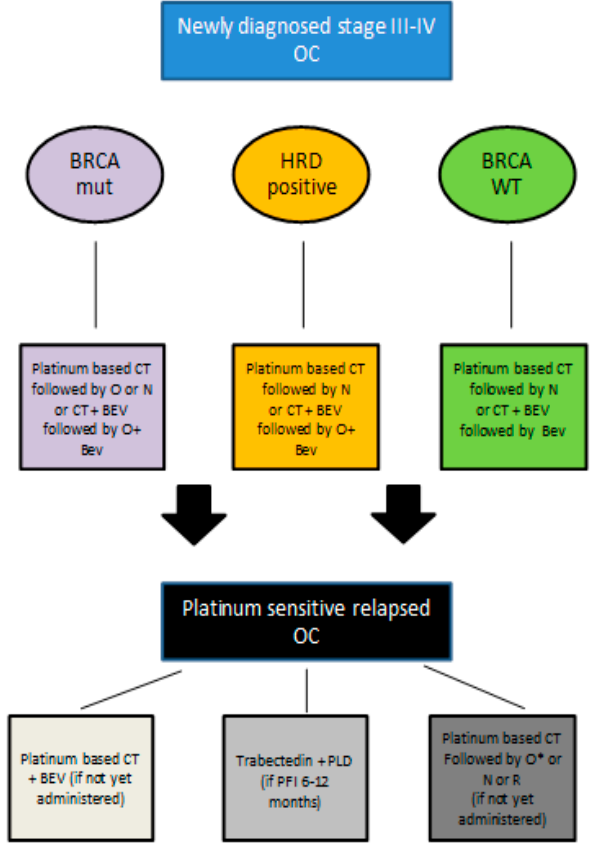
Figure 2. Proposed therapeutic algorithm for the treatment of advanced and relapsed epithelial ovarian cancer according to EMA indication. Legend: CT = chemotherapy; O = olaparib; N = niraparib; BEV = bevacizumab; PFI = platinum free interval; R = rucaparib.